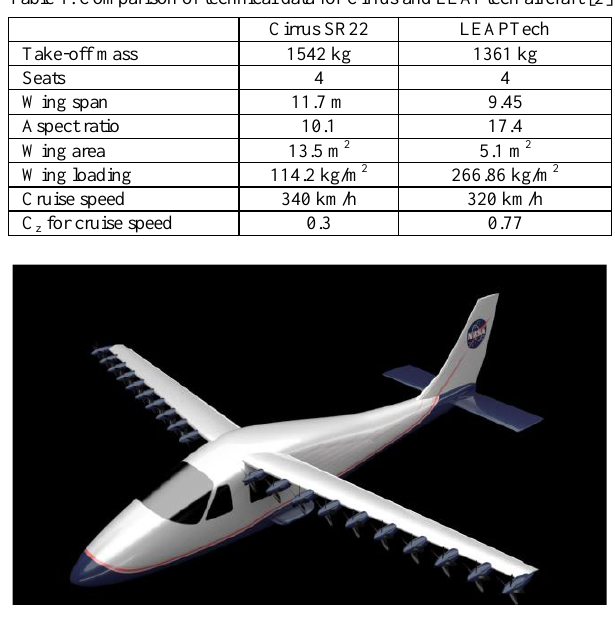
Fig. 6. LEAPTech concept aircraft